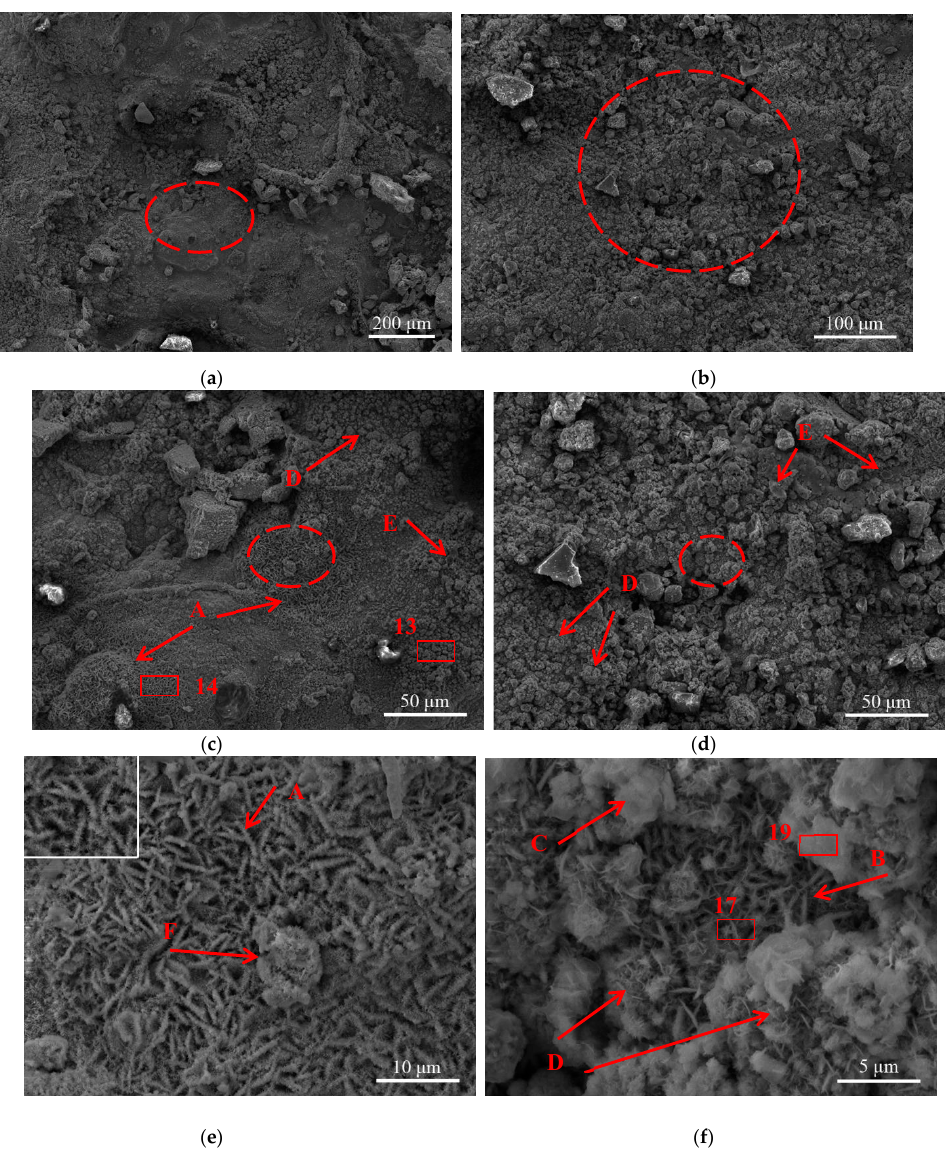
Figure 5. Surface microscopic morphologies of the rust layer and EDS analyses after 12 months of atmospheric exposure.